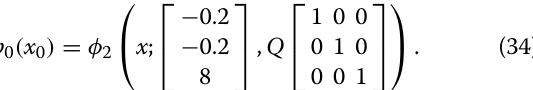
Table 6 Average coverage probabilities (in %) of the 95% HPD confidence set for ( x n ,1 , x n ,2 ) based on the TS procedure